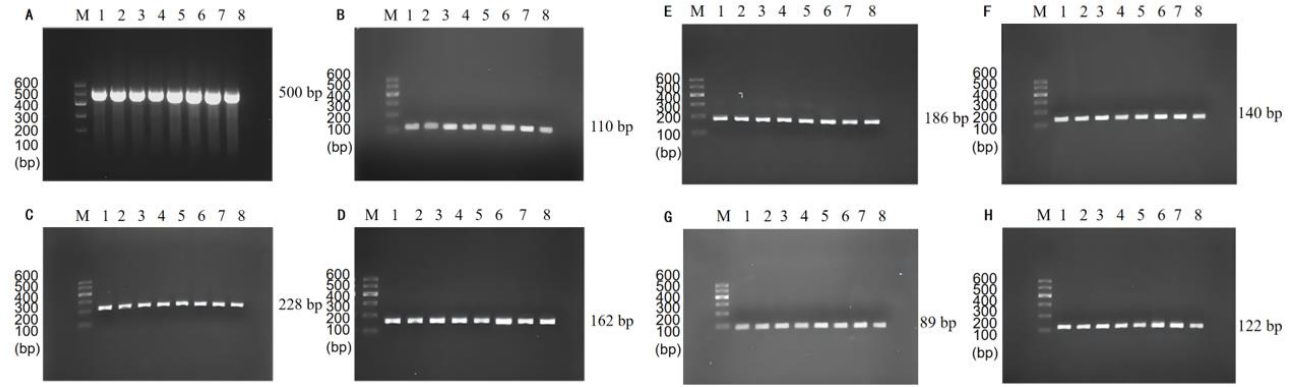
Figure 1. Single PCR amplification at the different annealing temperatures. Lane M: DNA marker B 600; Lane 1~8: Annealing temperature is 48 °C, 49 °C, 50 °C, 51 °C, 52 °C, 53 °C, 54 °C, and 55 °C, respectively. ( A ) P. putida ; ( B ) E. coli O157:H7; ( C ) V. vulnificus ; ( D ) L. monocytogenes ; ( E ) C. sakazakii ; ( F ) S. flexneri ; ( G ) V. parahaemolyticus ; ( H ) V. alginolyticus .